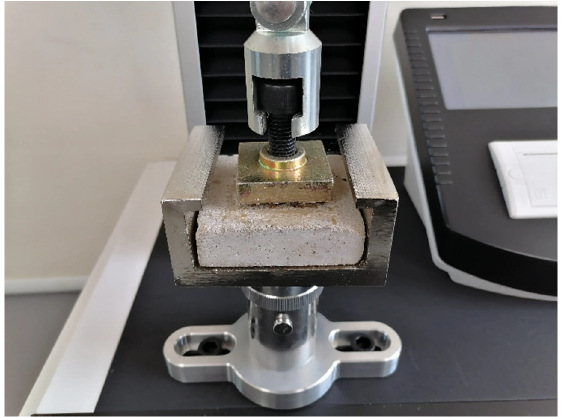
Figure 2. Tensile adhesive strength test.